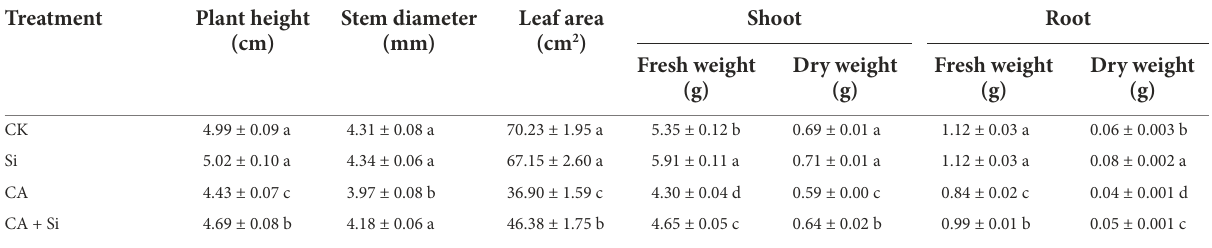
TABLE 2 Effect of exogenous Si on the plant height, stem diameter, leaf area, and biomass of cucumber seedlings under cinnamic acid (CA)- induced autotoxicity stress.